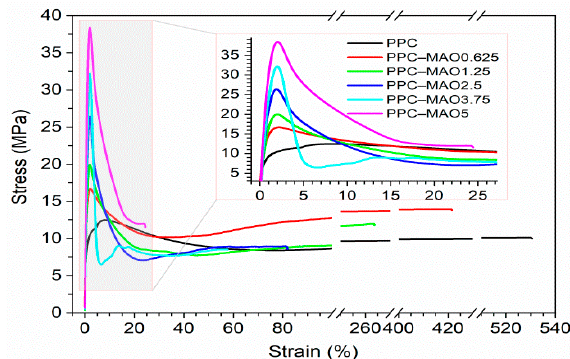
Figure 3. The strain-stress curves for PPC and PPC–MAO with networks.